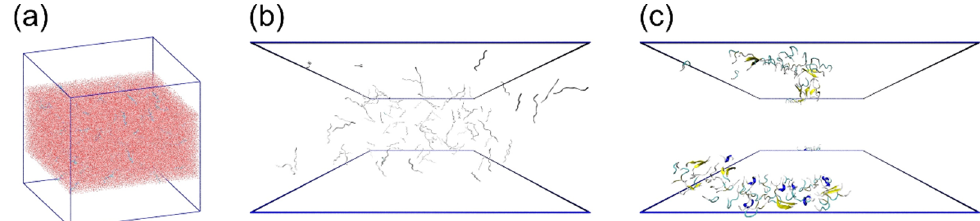
Figure 1. ( a ) Initial conformation of 100 A β (16–22) peptides (blue) and water molecules (red) with air–water interfaces. Side views of the ( b ) initial and ( c ) final conformation of A β (16–22) peptides. The water molecules are not shown here. The blue frames indicate the air–water interfaces. Reprinted with permission from Reference [45]. Copyright 2020 American Institute of Physics.